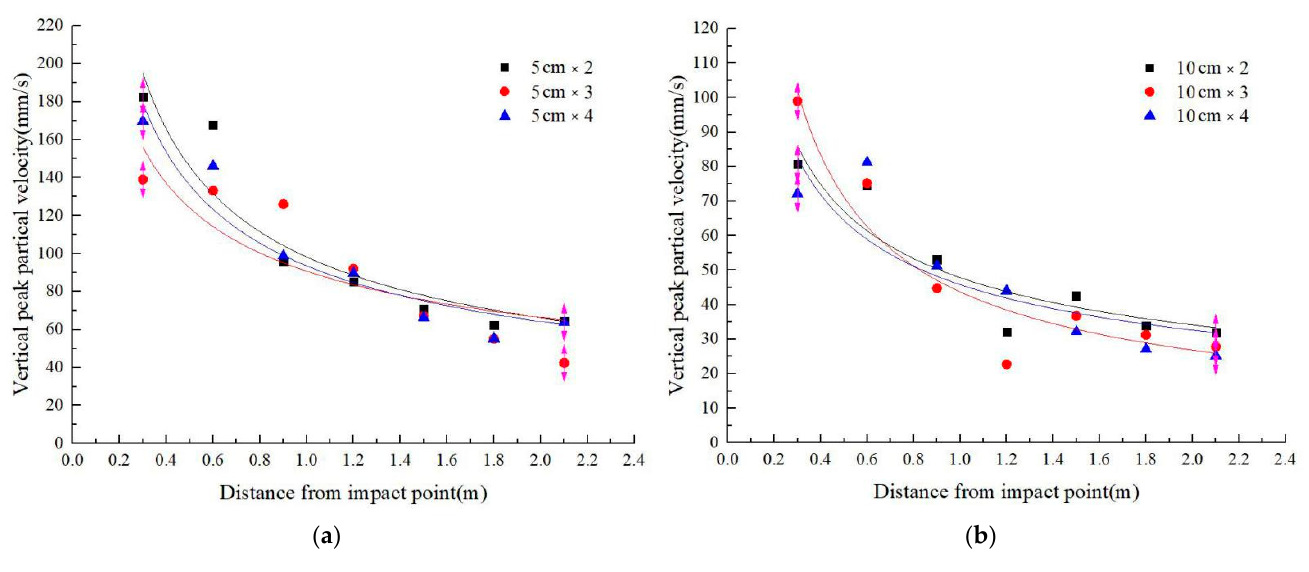
Figure 12. The impact test under the same thickness but different numbers of slabs: ( a ) 5 cm layer thickness multi-layer plate; ( b ) 10 cm layer thickness multi-layer plate. Table 3. The fitting parameters of the vertical peak particle velocity attenuation curve under different test conditions.